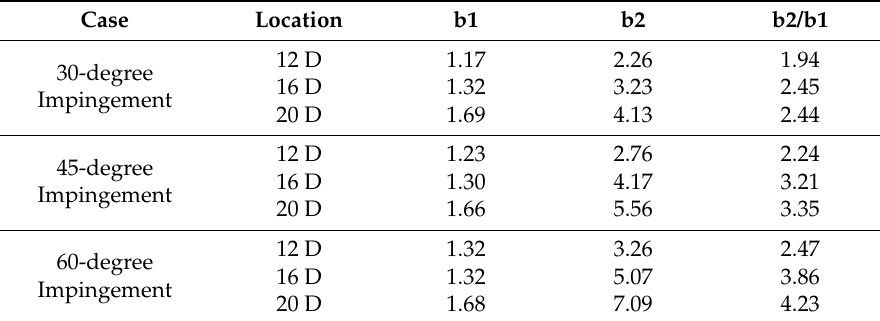
Table 2. Growth profile of resultant jet in y and z direction.